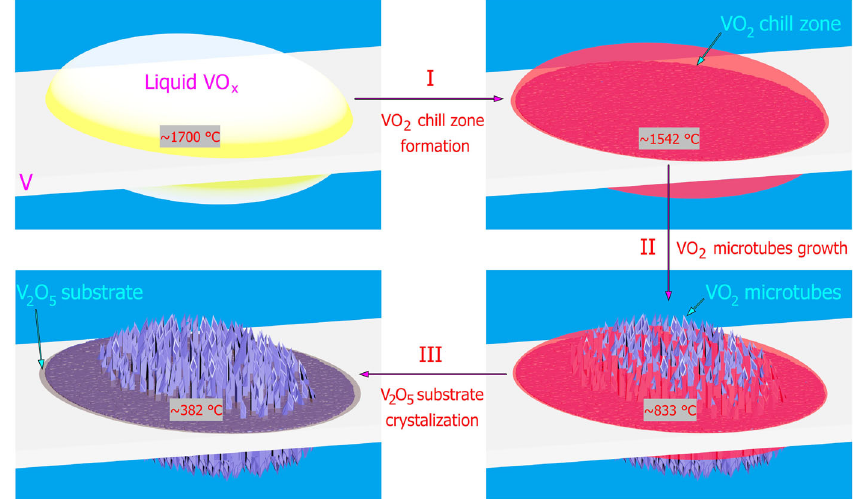
Fig. 4 Schematic illustrations of growth process of single crystal VO 2 microtube arrays. I VO 2 equiaxed crystals nucleate at the V foil surfaces and form the chill zones at ~1542 °C. II Single crystal VO 2 microtubes grow from the chill zones and form the arrays at ~833 °C. III Residual liquid VO x crystallize and form the V 2 O 5 substrate at ~382